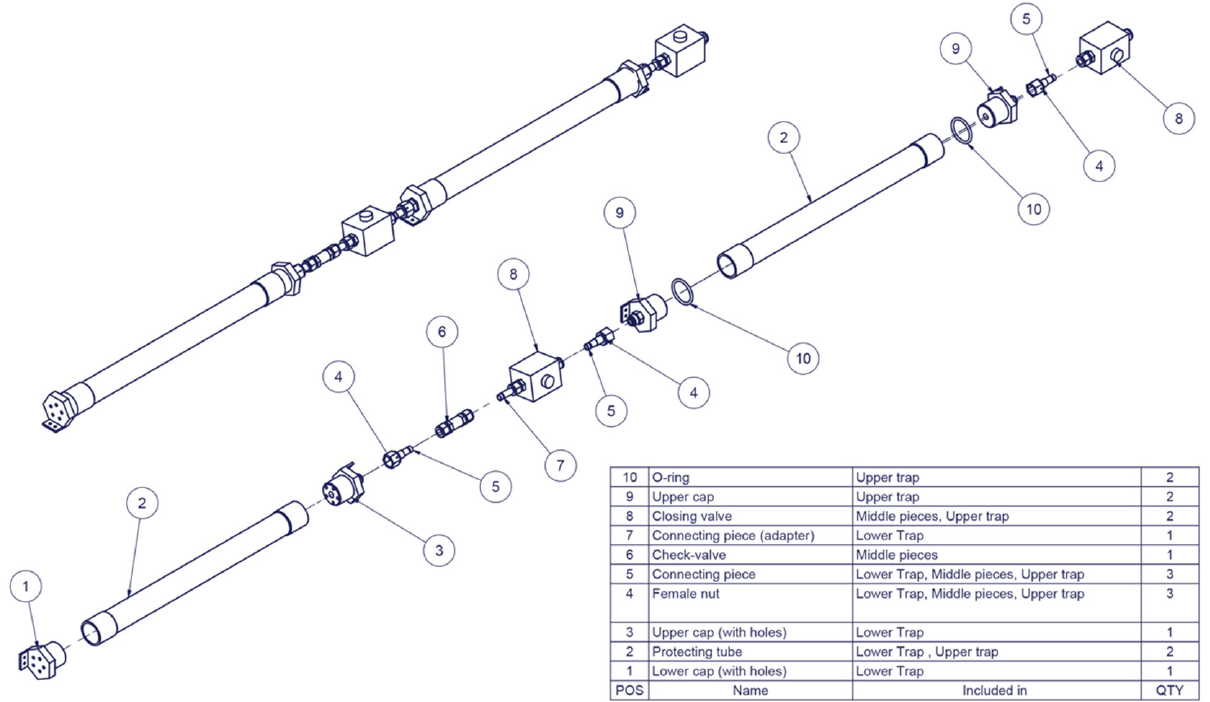
Figure 1. Schematic diagram of the in situ biofilm trap. More details are shown in Figures S1 and